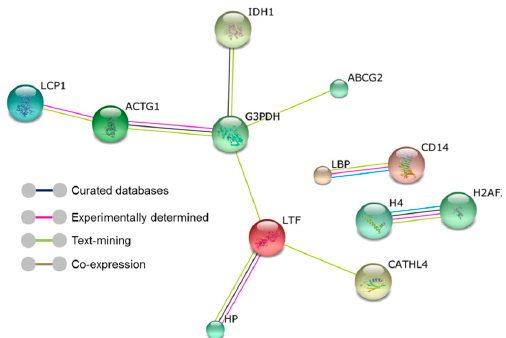
Figure 2. The protein–protein interaction network analysis using Search Tool for the Retrieval of Interacting Genes/Proteins (STRING) software. The nodes represent individual proteins enriched in the analysis and the edges (connecting lines) reflect the functional associations derived from various online resources. Protein nodes which are enlarged indicate the availability of 3D protein structure information. LBP = Lipopolysaccharide-binding protein, CD14 = Monocyte differentiation antigen, H4 = Histone, H2AFJ = Histone H2A, LTF = Lactotransferrin, CATHL4 = Cathelicidin-4, HP = Haptoglobin, IDH1 = Isocitrate dehydrogenase, ABCG2 = ATP-binding cassette subfamily G member 2, GAPDH = Glyceraldehyde-3-phosphate dehydrogenase, ACTG1 = Actin cytoplasmic 2, and LCP1 = Uncharacterized protein.